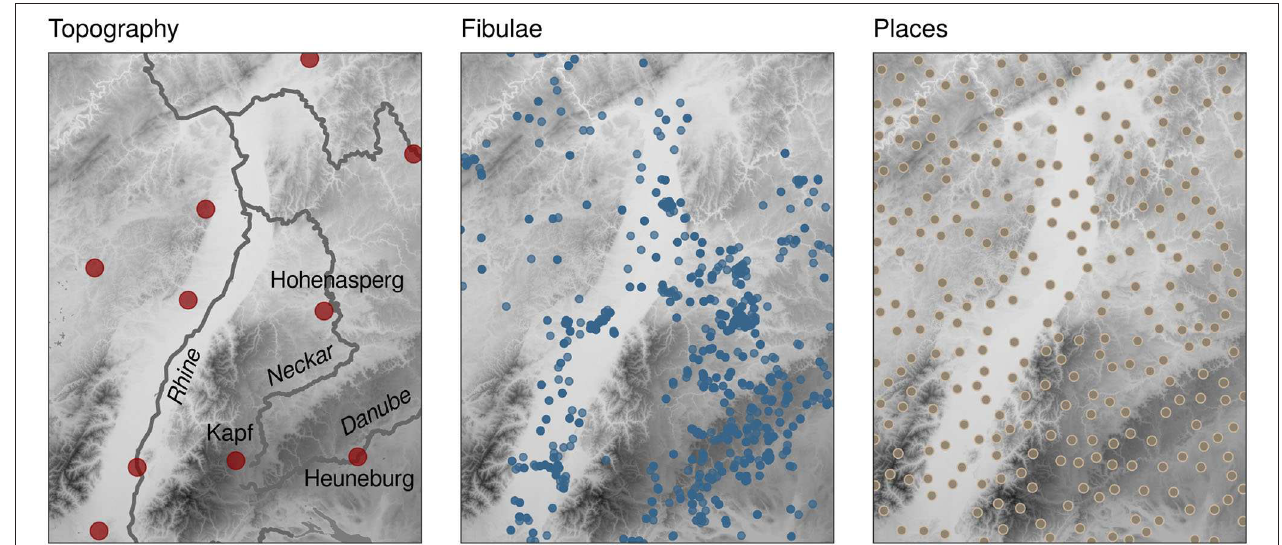
FIGURE 1 | Area of interest. Left : rivers and Princely Seats; Center : Fibulae; Right : simulated site locations and locations of Princely Seats.